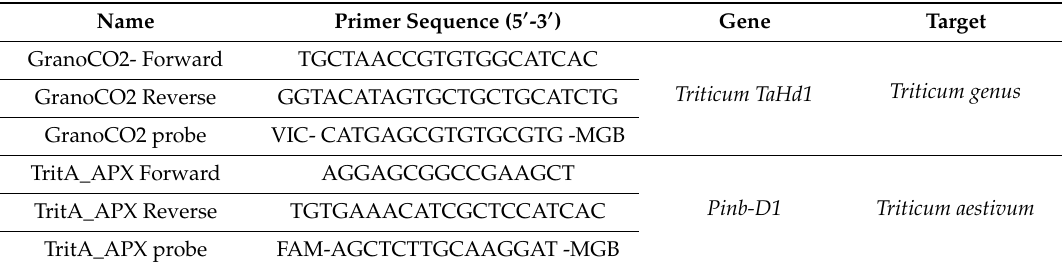
Table 1. Primers and